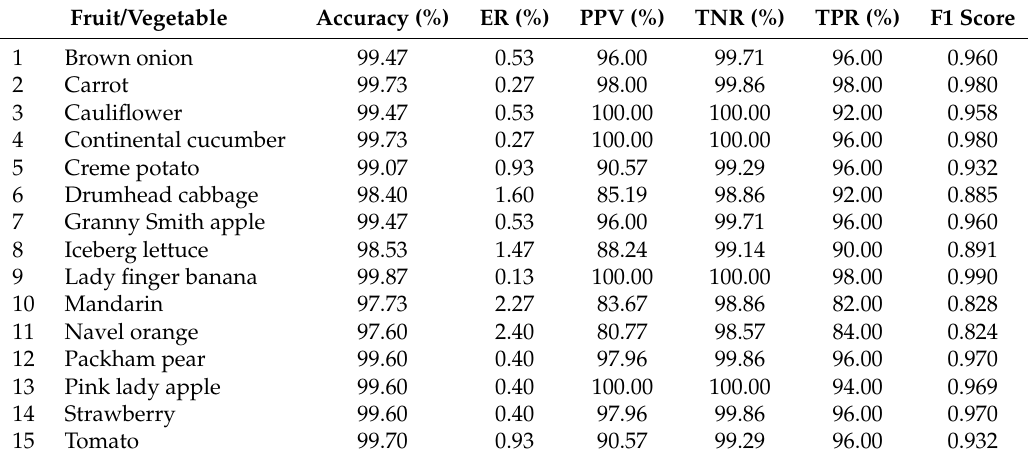
Table 8. Classification metric comparison for AdaBoost-optimised CNN based fruit and vegetables